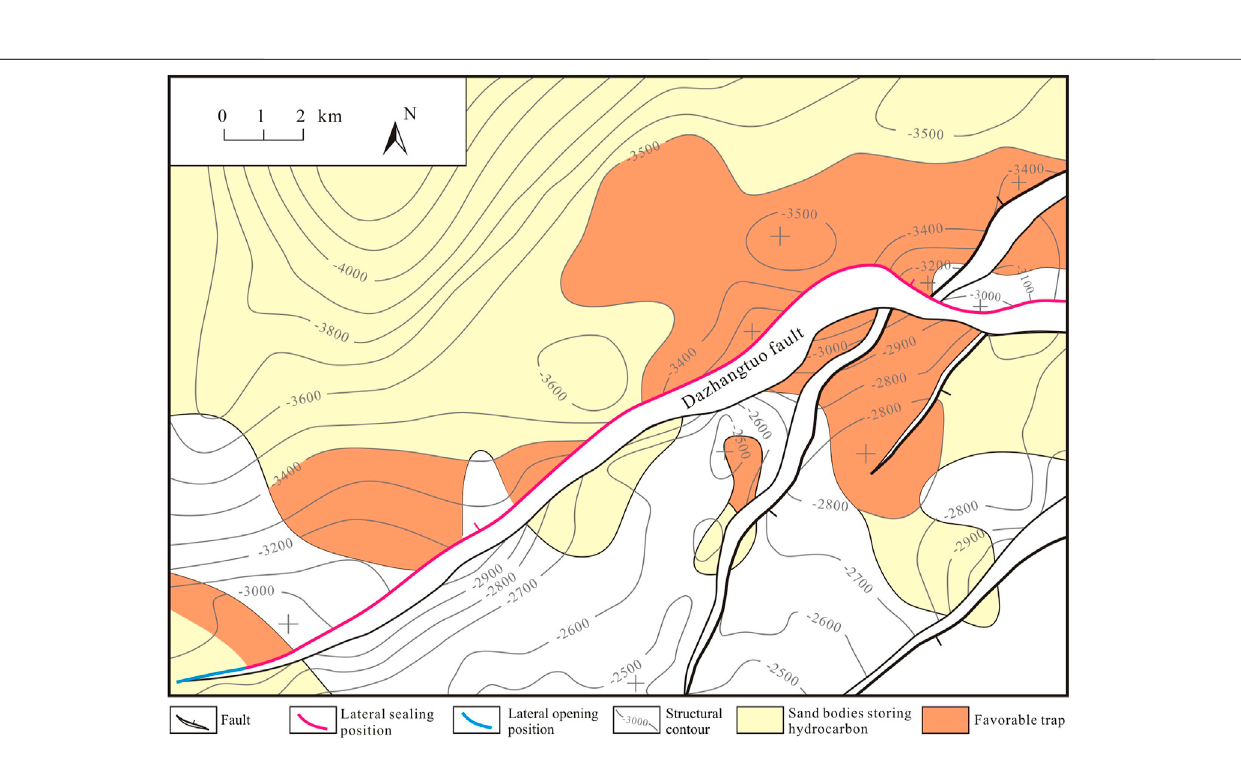
Frontiers in Earth Science |